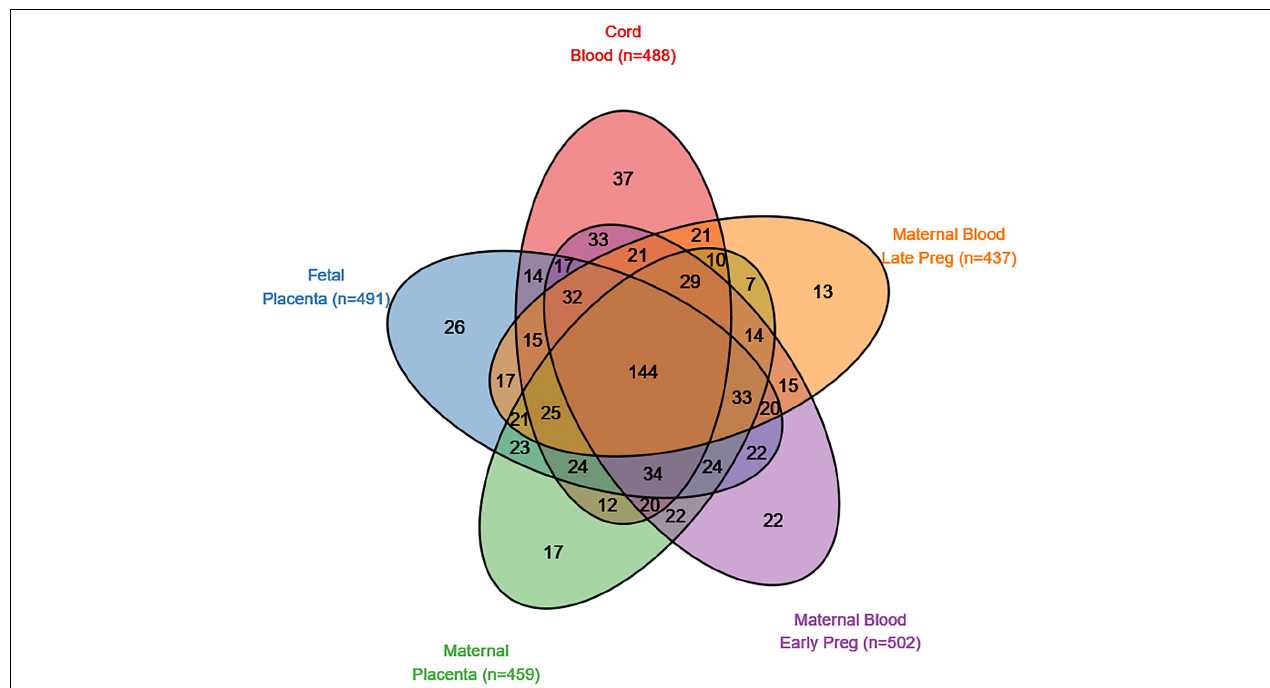
FIGURE 2 | SFARI genes with a CpG site nominally associated ( p < 0.05) with autism spectrum disorder in five tissues (maternal blood from early pregnancy, maternal blood from late pregnancy, cord blood, the fetal side of the placental tissue, and the maternal side of the placental